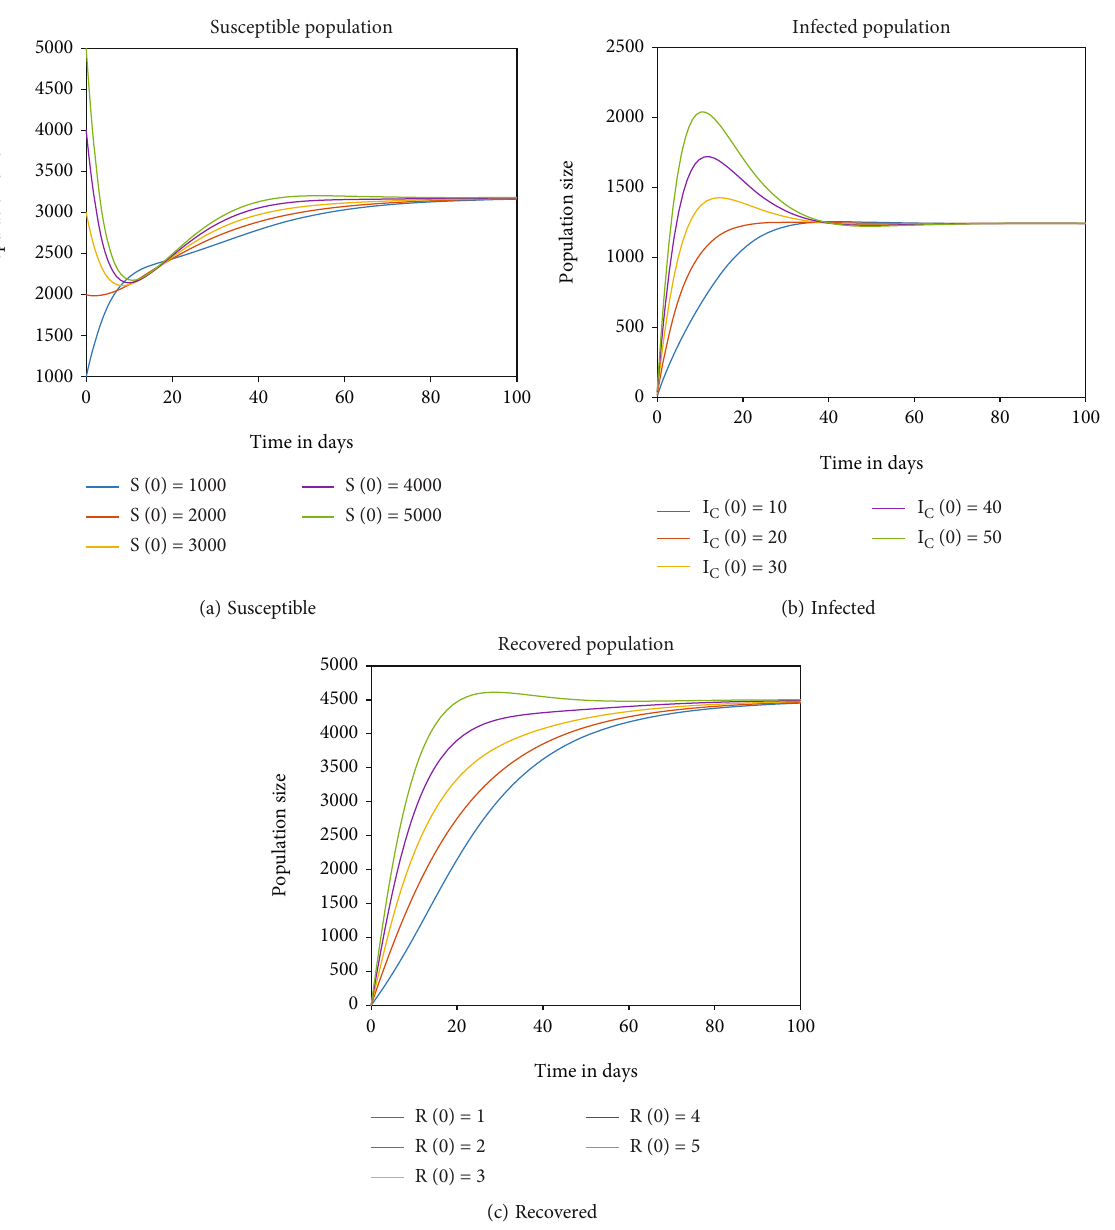
Figure 5: The stable solution curves of the susceptible, infected, and recovered populations for di ff erent initial values of the COVID-19 only model use parameter values of the Figure 4 in which its basic reproduction number is greater than unity ( R C 0 = 3 : 2707